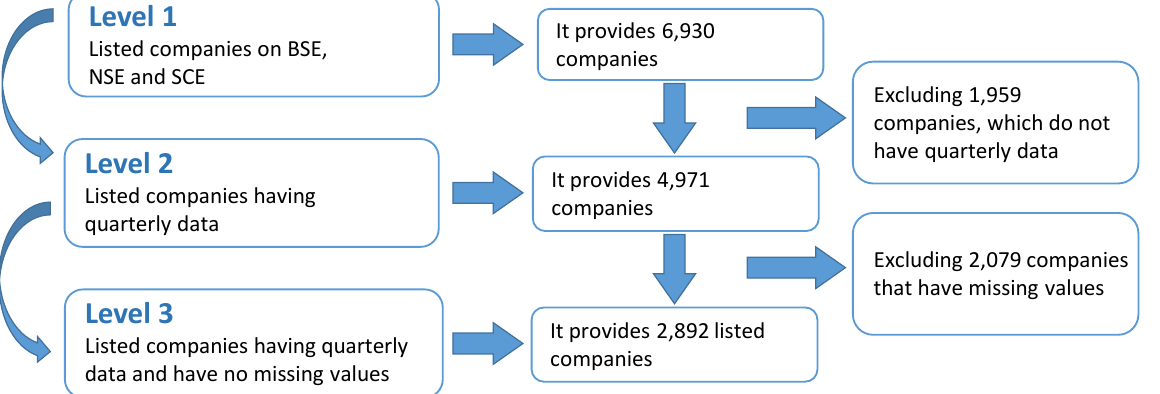
Figure 1. Summary of study selection